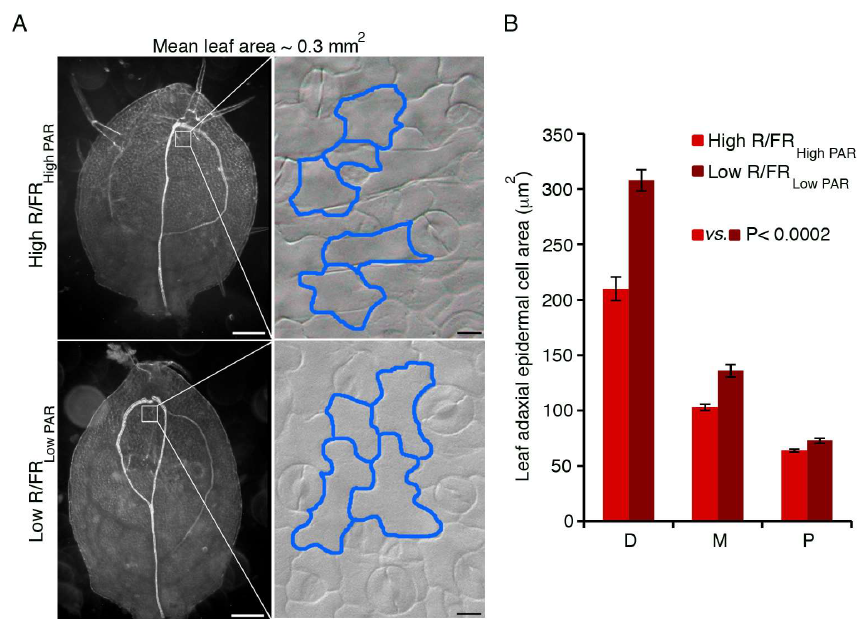
Figure 3. Shade affects adaxial epidermal cell expansion in the Arabidopsis leaf. ( A ) Dark-field images of cleared first/second leaves of wild type grown for eight days in high R/FR High PAR (high R/FR High PAR ), or for four days in high R/FR High PAR and then for 5.5 days in low R/FR Low PAR (low R/FR Low PAR ), respectively. The insets show a paradermal view of leaf adaxial epidermis; the borders of a few cells have been highlighted manually with a blue line. Light outputs were as previously reported [9]. Scale bars: ( A ), 100 µ m; insets, 10 µ m. ( B ) The graph shows the mean epidermal cell area at three positions along the proximo-distal leaf axis, distal (D), median (M) and proximal (P) in the two light conditions. At least 100 adaxial epidermal cells in 10 leaves were analyzed for each condition. Statistical analysis was performed as described